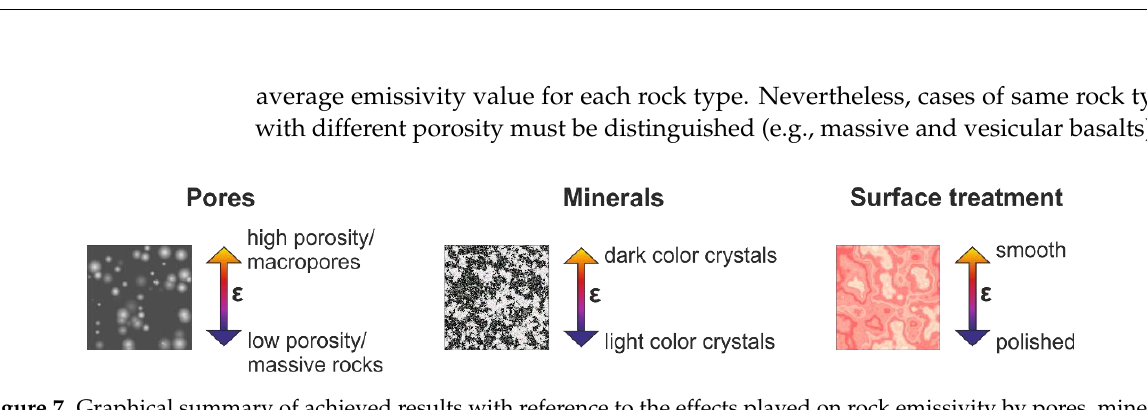
Figure 7. Graphical summary of achieved results with reference to the effects played on rock emissivity by pores, minerals and surface condition.